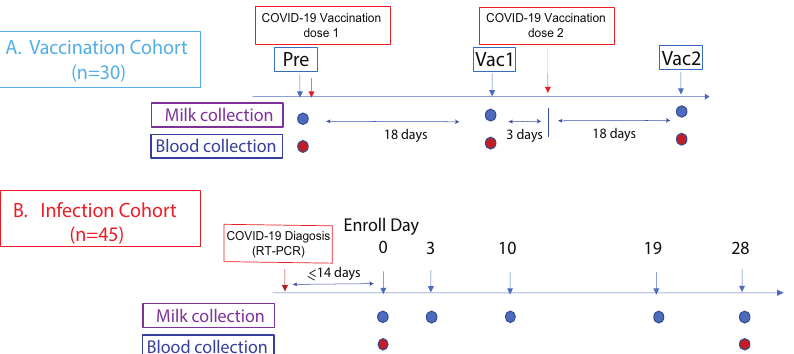
Figure 1. Study cohorts and experimental design. This prospective study consist of two cohorts: ( A ) The vaccination cohort enrolled lactating parents (n = 30) older than 18 years without COVID-19 infection history and scheduled to receive either the Pfizer-BioNTech/BNT162b2 or Moderna/mRNA- 1273 mRNA vaccination. The human milk and fingerstick blood samples were collected before vaccination and 18 days after the first and second doses each. ( B ) The infection cohort enrolled lactating parents who had received an RT-PCR COVID-19 diagnosis within the previous 14 days. The human milk samples were collected at enrollment day 0, then on days 3, 10, 19, and 28. Fingerstick blood samples were collected on days 0 and